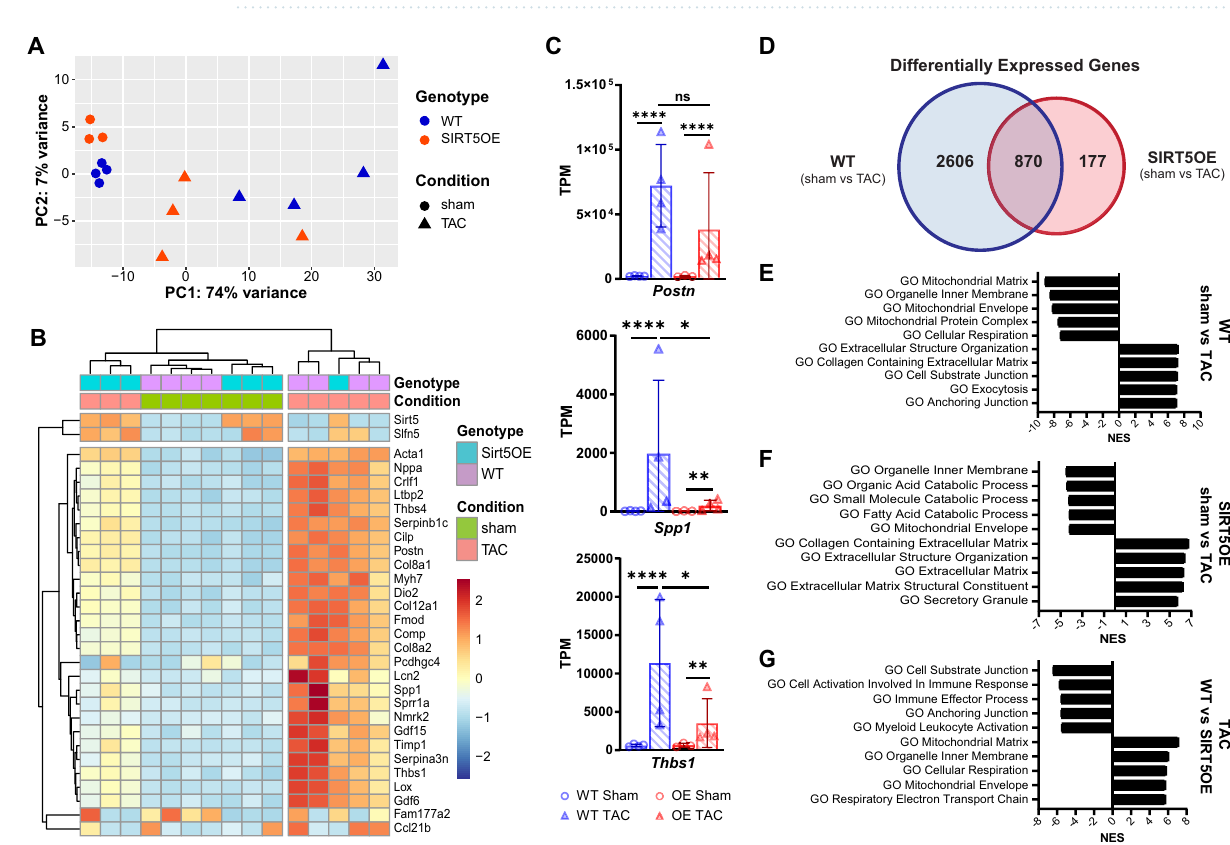
Figure 3. Transcriptomic analysis of heart tissue four weeks after TAC identifies a dampened transcriptional response to pressure overload in SIRT5OE mice. (A) Principal component analysis (PCA) of RNA-sequencing data of the four groups of mice [WT sham ( n = 4), WT TAC ( n = 4), SIRT5OE sham ( n = 3) and SIRT5OE TAC ( n = 4)]. (B) Hierarchical clustering analysis (HCA) of the RNA-seq data based on the top 30 genes, determined by greatest variance from the mean. Genes with higher expression compared to the mean skew red; genes with lower expression compared to the mean skew blue. (C) Postn , Spp1 , and Thbs1 mRNA levels measured by RNA- seq. (D) Venn Diagram comparing exclusive and overlapping differentially expressed genes in the WT (sham vs TAC) mice and the SIRT5OE (sham vs TAC) mice. (E–G) Top five positively and negatively enriched Gene Ontology (GO) pathways from the indicated comparisons, determined by gene set enrichment analysis (GSEA). NES: normalized enrichment score. All listed pathways were significantly enriched with a false discovery rate (FDR) <